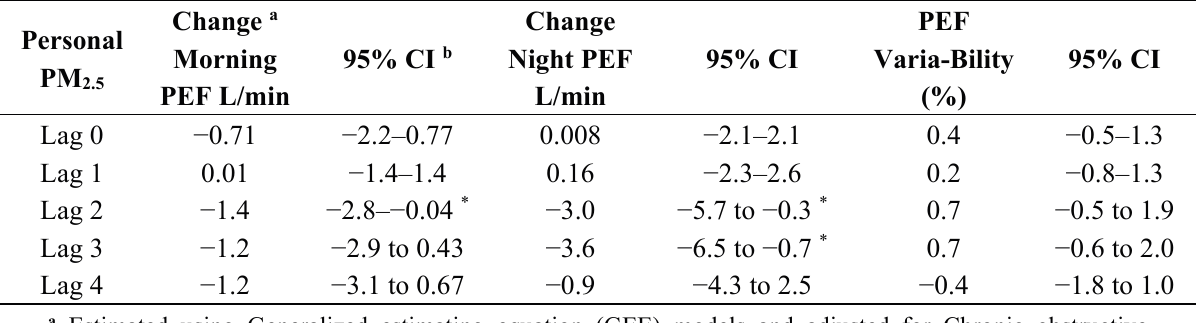
Table 3. Association of peak expiratory flow (PEF) and personal particulate matter with an aerodynamic diameter less than 2.5 µm (PM 2.5 ), Mexico City.